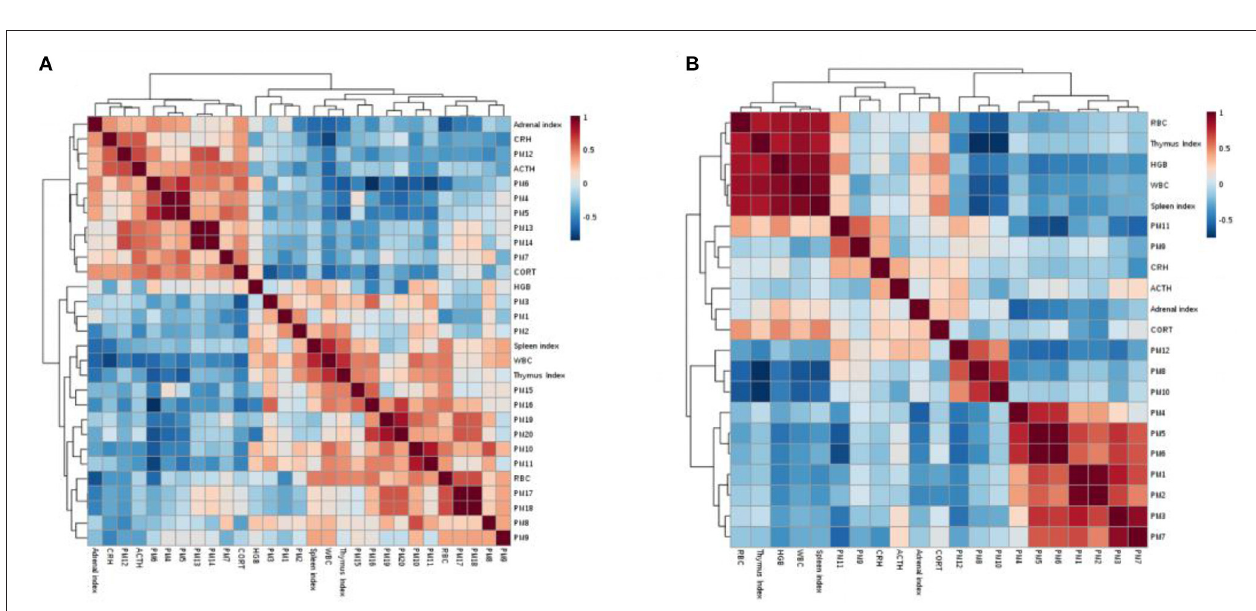
FIGURE 10 | Serum (A) and cerebral cortex (B) correlation analysis between potential biomarkers and biochemical indices.